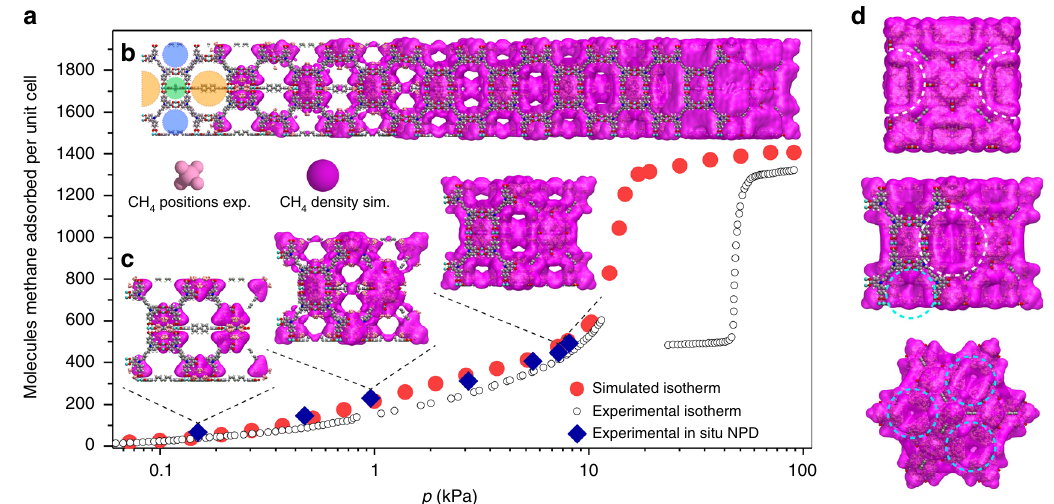
Fig. 5 Methane distribution in DUT-49. a Simulated (red circles) and experimental (open symbols) methane adsorption isotherm of DUT-49 at 111 K including points at which NPD patterns were recorded (blue diamonds). b Structure of DUT-49 with increasing population of pores with methane upon pressure increase, including on the left trimodal pore system: octahedral (oct, orange), tetrahedral (tet, blue), cuboctahedral (cub, green). Experimentally re fi ned methane positions in light pink, simulated methane density in pink. c Visualisation of DUT-49 unit cell at selected loadings which correspond to experimentally investigated pressure. d Illustration of methane- fi lled pores of DUT-49 unit cell in the region of NGA viewed along (100) direction (top), (110) direction (middle), and (111) direction (bottom). For detailed mechanism see Supplementary Movie